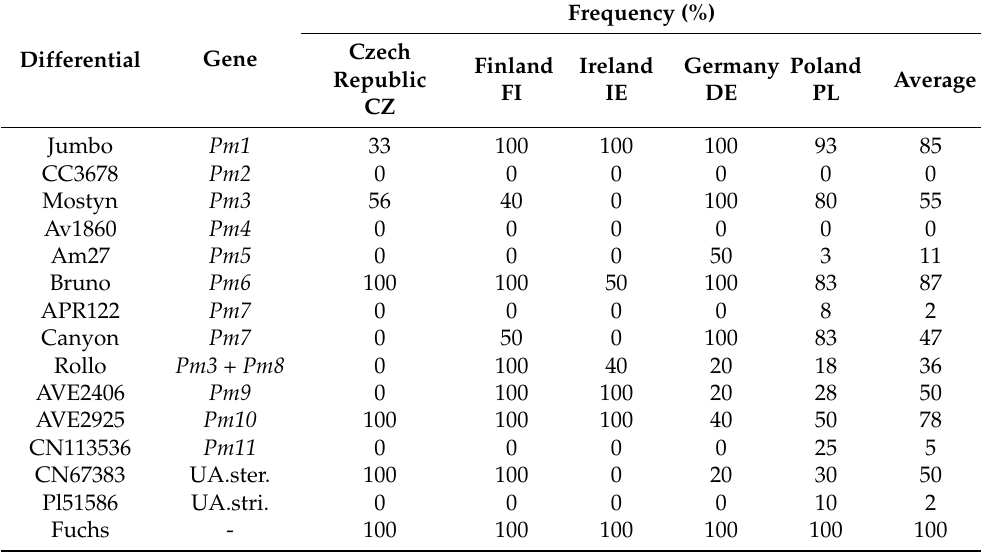
Frequency (%) Czech Average IE DE PL CZ